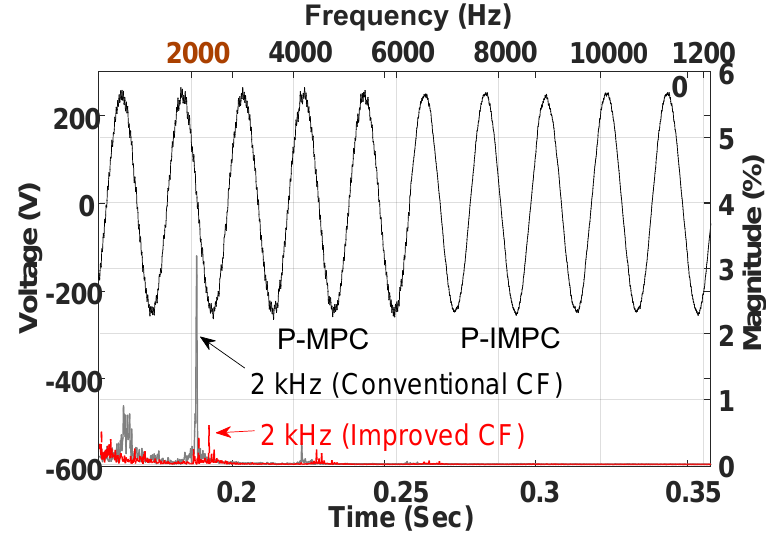
Figure 12. Obtained experimental voltage and spectrum results using the conventional and improved CFs. F sw = 2 kHz, C f = 60 µ F, L f = 5